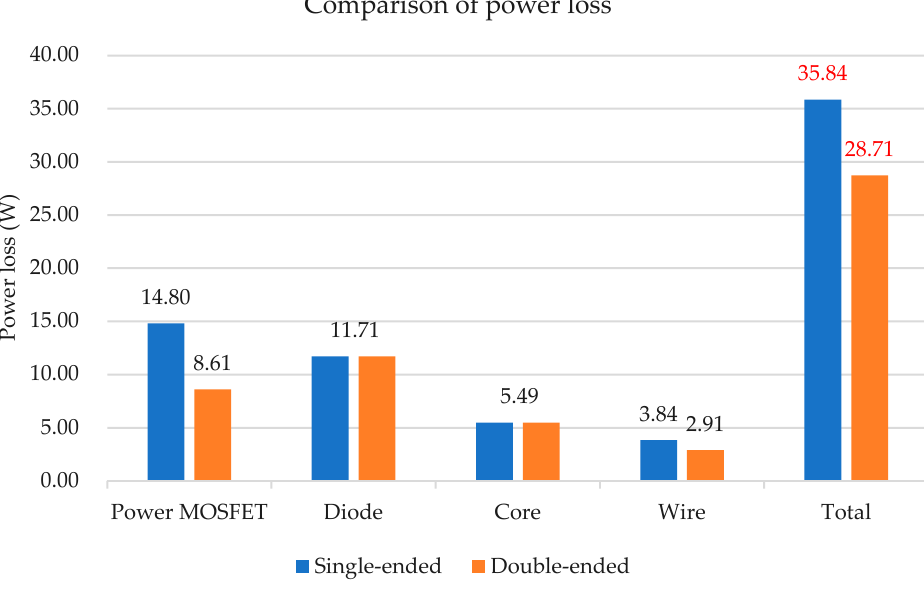
Figure 14. Prototype of forward converters: ( a ) single-ended forward converter; ( b ) double-ended forward converter.